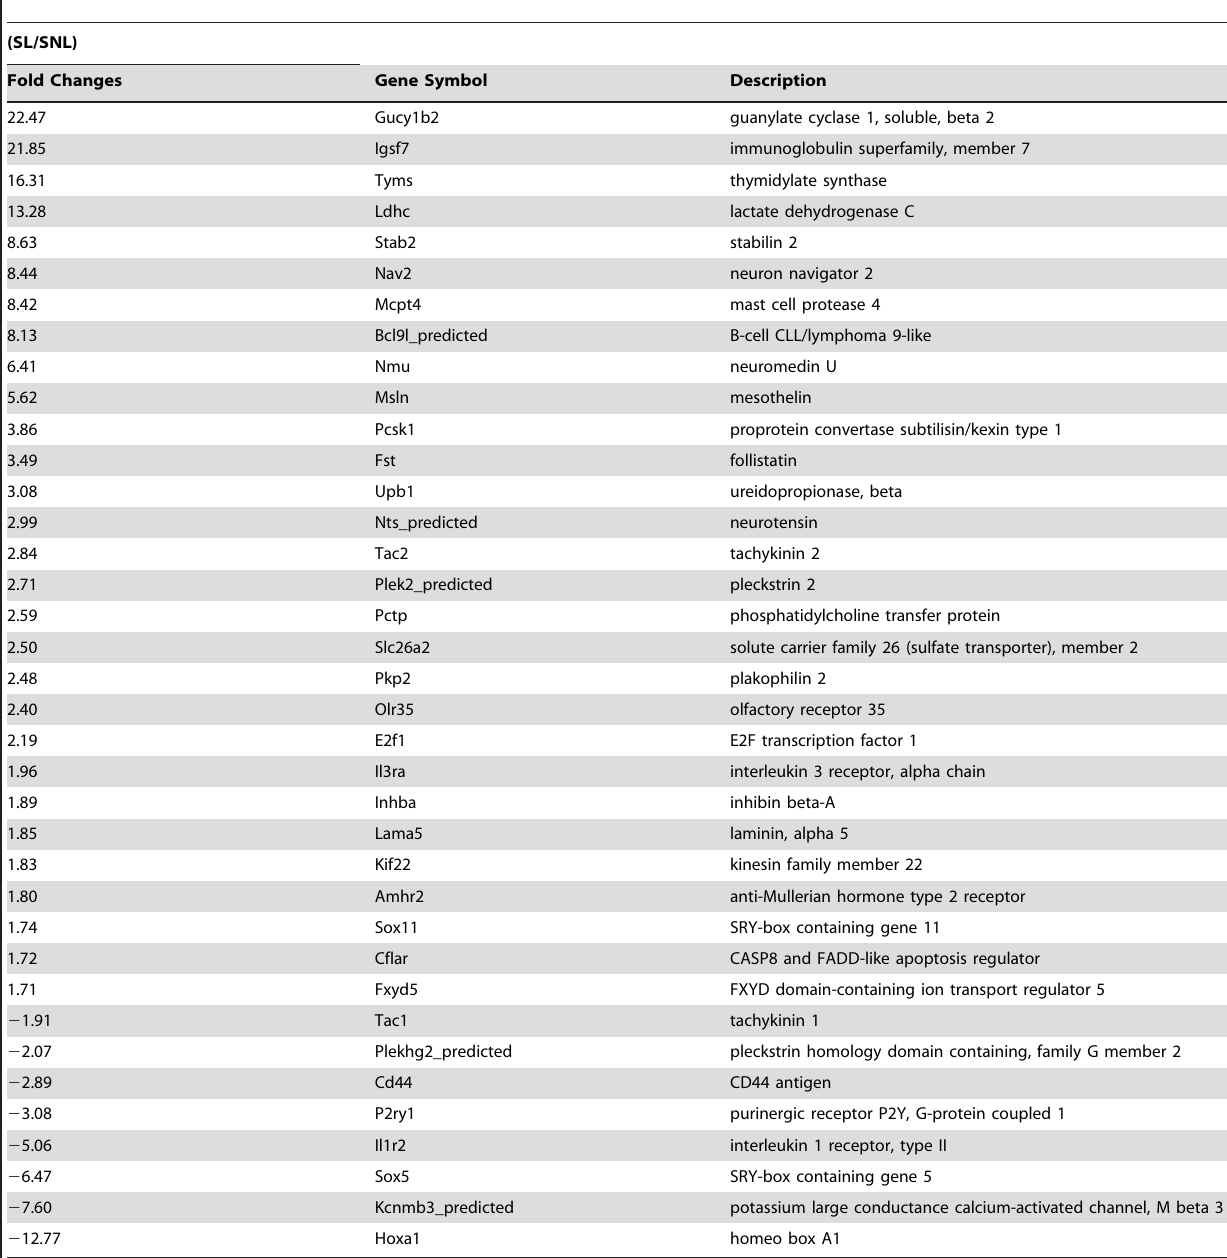
Table 2. Partial list of genes showing changes in the DA-depleted striatum of hemiparkinsonian rats.